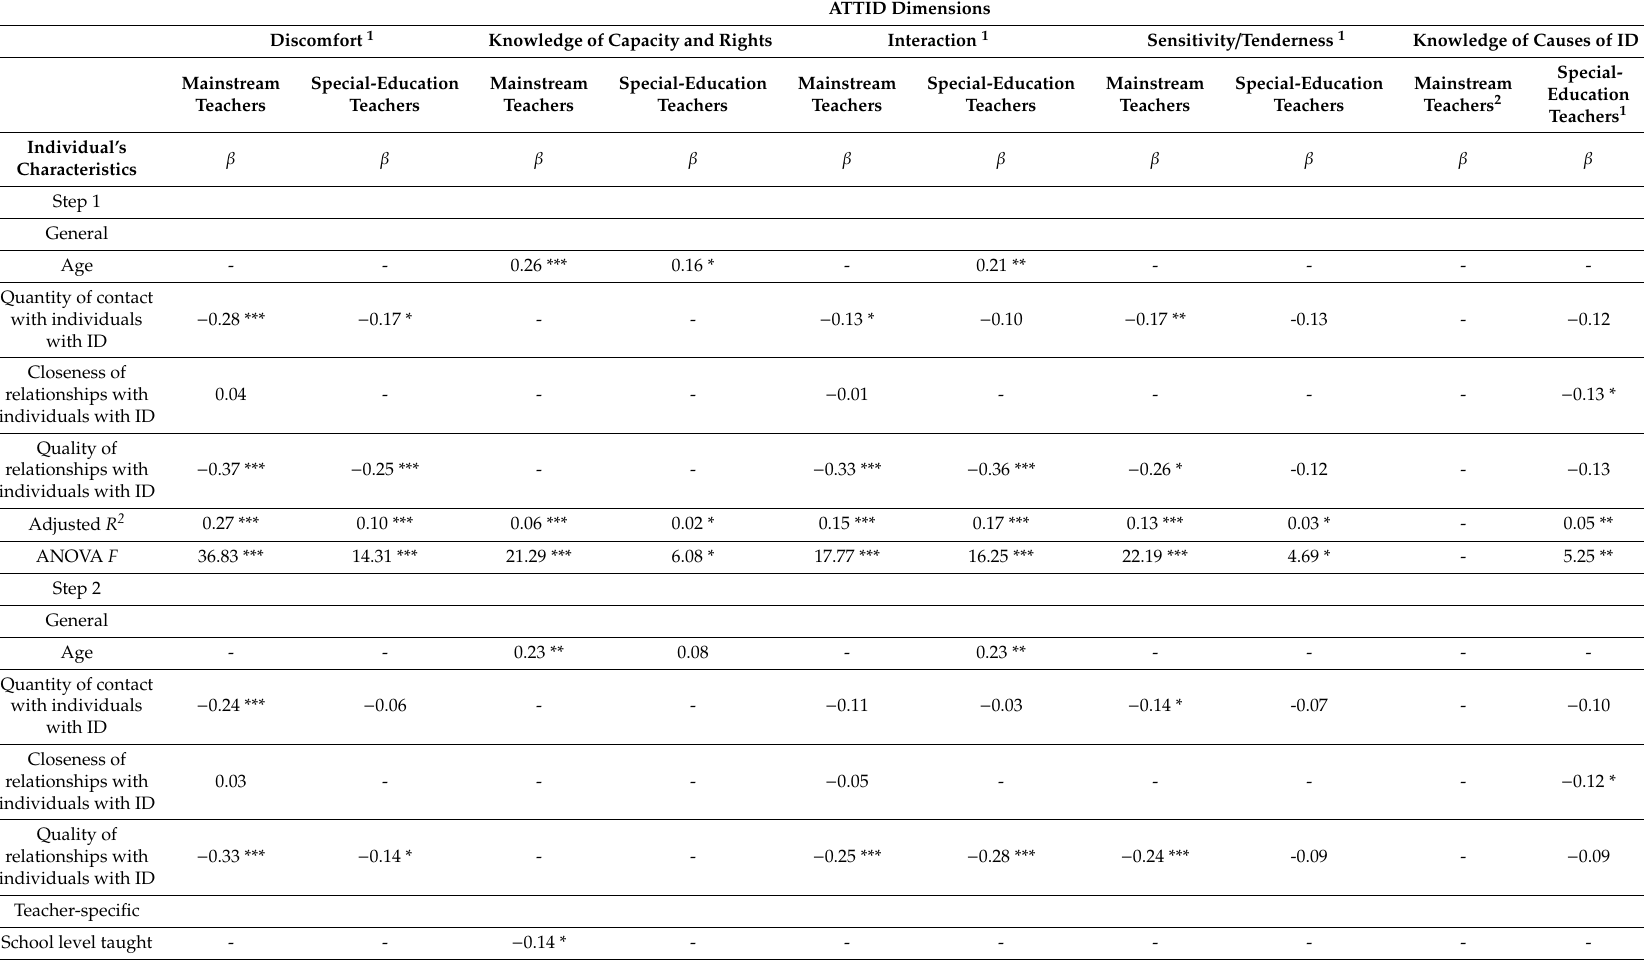
Table 4. Hierarchical multiple regression analyses of general and teacher-specific characteristics for each dimension of the ATTID questionnaire for mainstream teachers and special-education